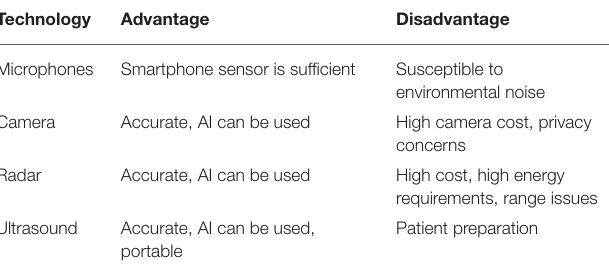
TABLE 1 | Different contactless technologies and their advantages and